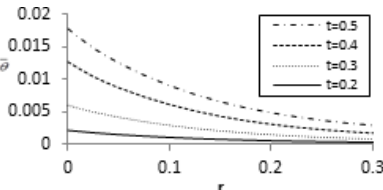
Figure 6: Distribution of temperature with the radius via RPL ℜ = 2 The displacement stress in thermopiezoelastic func- tionally graded rod against the radius of rod for diverse val- ues of concentration constants in RPL model is detected in Figures 4 and 5. The displacement stress is follows diminish